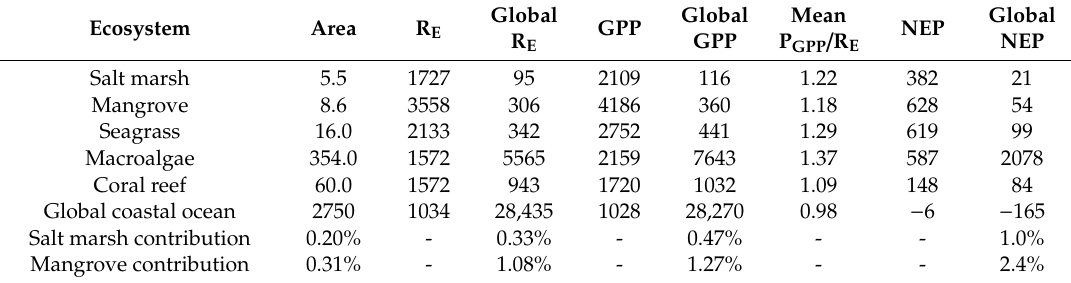
Table 6. Contribution of salt marshes and mangroves to carbon balance in the global coastal ocean compared with other marine ecosystems. Global seagrass area from [195], macroalgae area from [196] and area of other ecosystems from [188], except the global coastal ocean [194], which encompasses estuaries, other wetlands, and continental shelves. Seagrass data [188] updated from [197–210] and macroalgae data from [211–236]. Plankton GPP and R in salt marshes from [237] and in mangroves from [52]. All other data from [188], except global coastal ocean data from [194]. Percentage contributions of salt marsh and mangrove NEP are based on comparison with sum of all ecosystem NEP plus the negative global coastal ocean NEP ( = 2217 Tg C a − 1 ). Percentage contributions of salt marsh and mangrove R C and GPP are based on comparison only with global coastal ocean R E and GPP. Abbreviations and units: R E (g C m − 2 a − 1 ) = ecosystem respiration (R C + R S + R WATER + R MICROALGAE